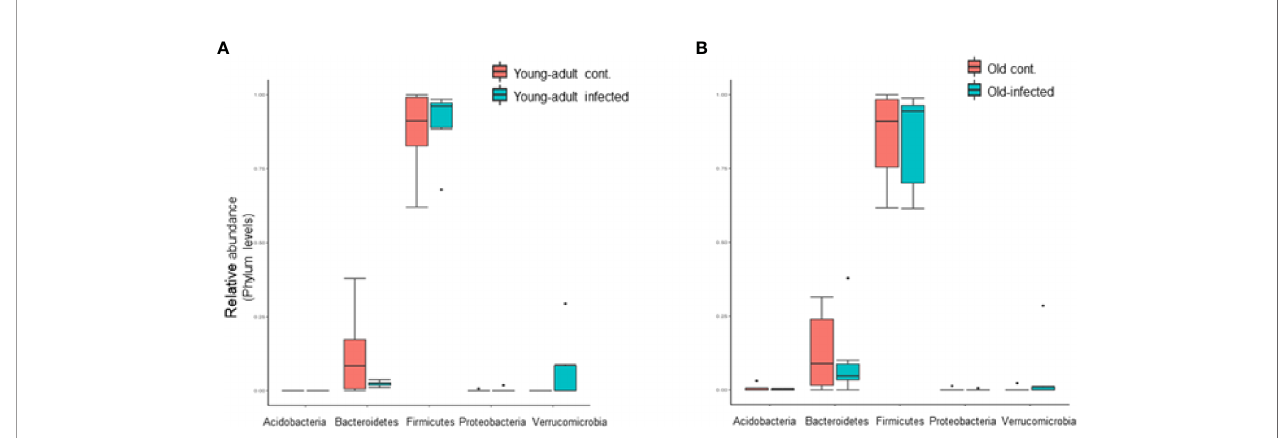
FIGURE 2 | Listeria monocytogenes infection induced changes in the relative abundance of fecal microbiota at the phylum level. (A) Relative abundance of major bacterial Phylum in young-adult control and L. monocytogenes -infected young-adult mice. (B) Relative abundance of Phylum bacteria in old control and old L.